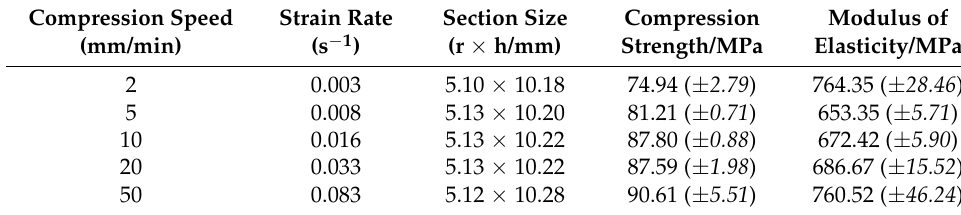
Table 8. Quasi-static compression experimental data of